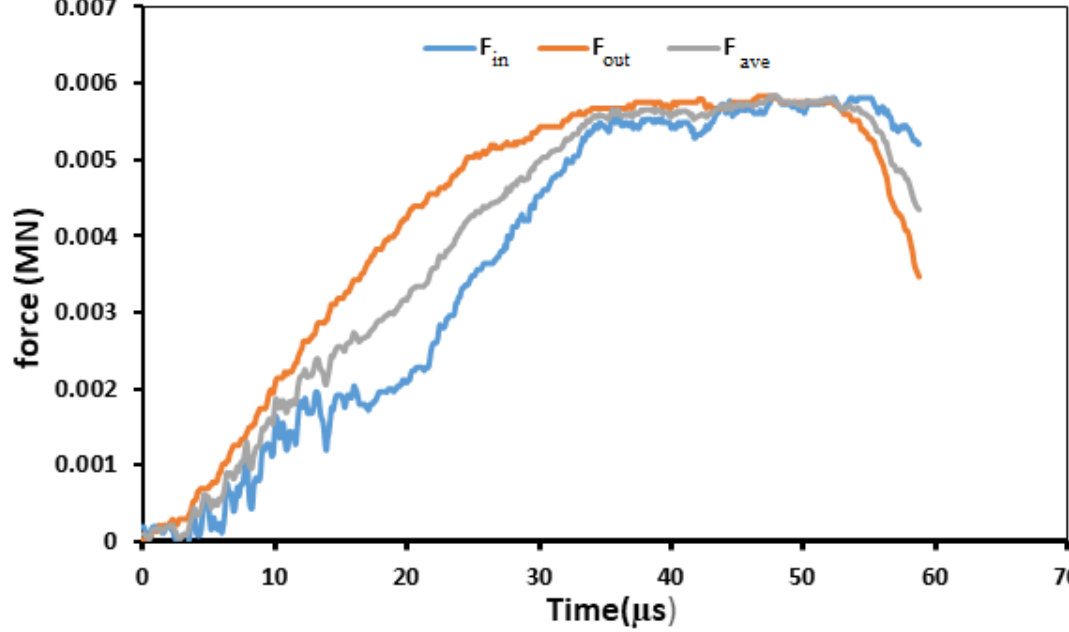
Figure 6. Forces in the two sides of the NSSS